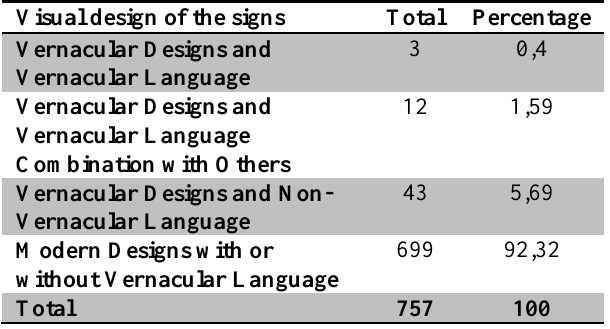
Tab. 3: Visual Architecture Design in Outdoor Signs in